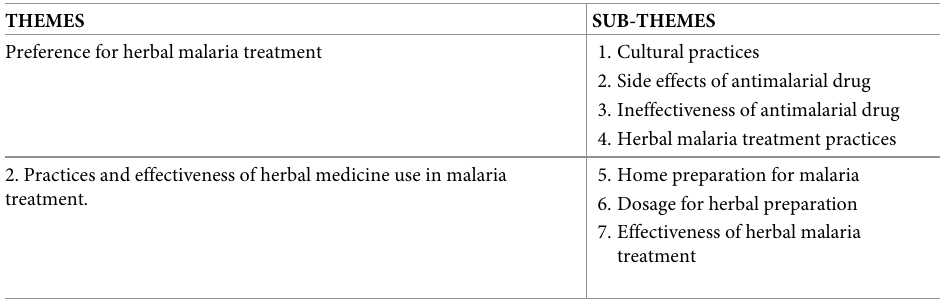
Table 2. Themes and